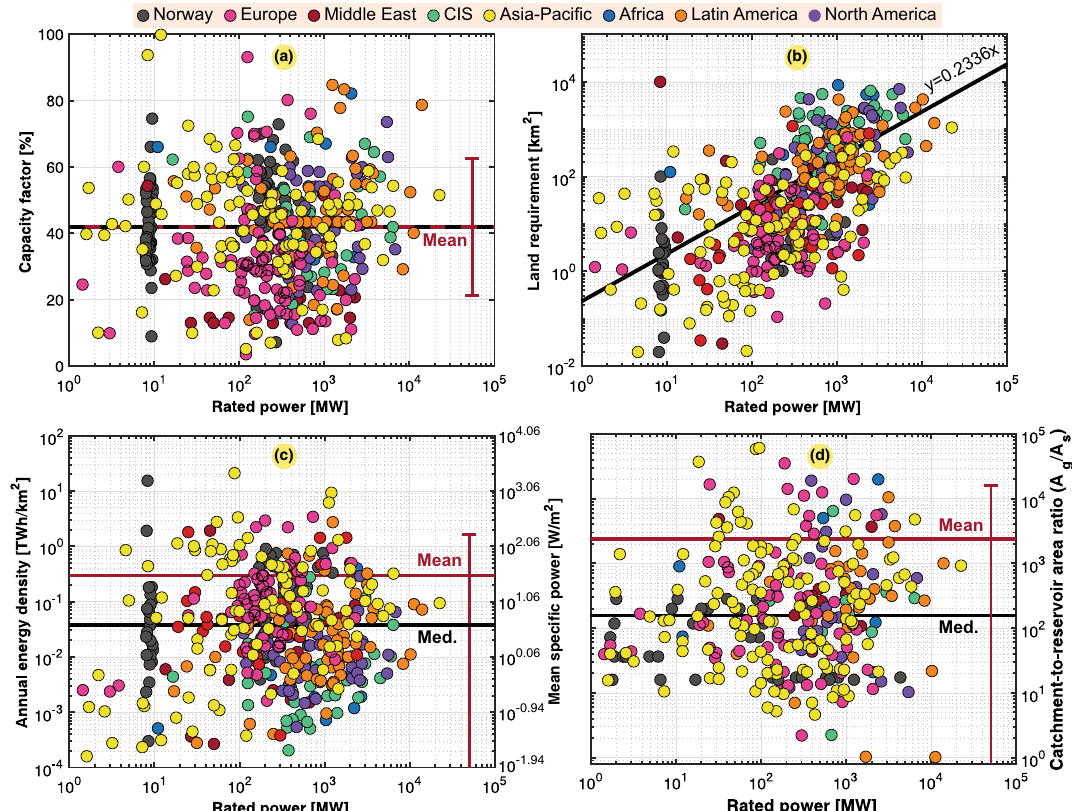
Figure 7. Scatter plots of 451 hydropower plants in the world, 71 in Norway, 68 in Europe, 21 in Middle East, 38 in the CIS, 98 in Asia Pacific, 12 in Africa, 34 in Latin America, and 26 in North America. Typical, mean, median, and fitted values are also included. ( a ) Capacity factor ( C g ). ( b ) Land use ( A g ). ( c ) Annual energy density ( ε g ) or mean specific power ( p g ). ( d ) Catchment-to-reservoir area ratio.